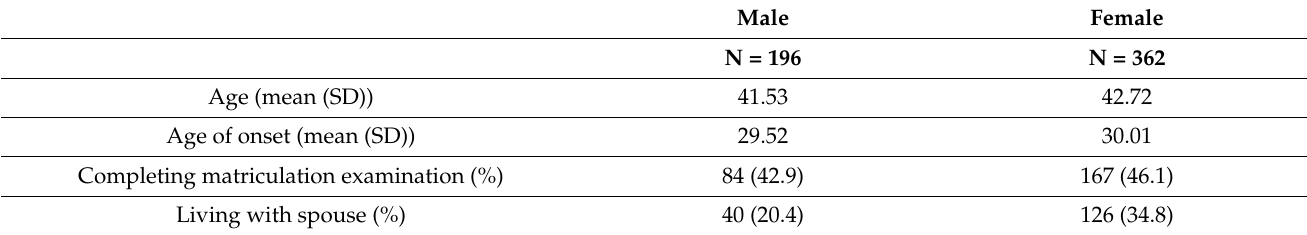
Table 2. Background factors and hazardous drinking PGS in male and female schizoaffective disorder